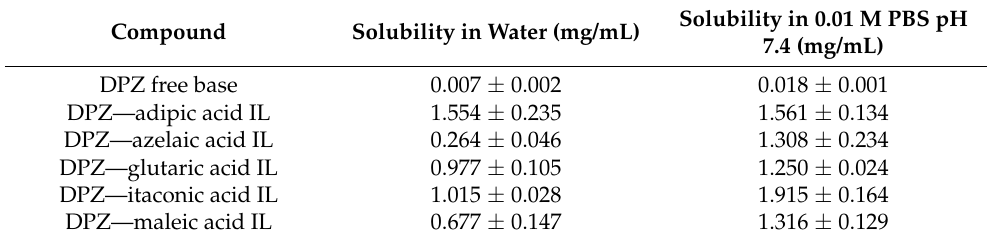
Table 2. Solubility of DPZ free base and DPZ ILs in water and 0.01 M PBS pH 7.4. mean ± S.D ( n = 3).